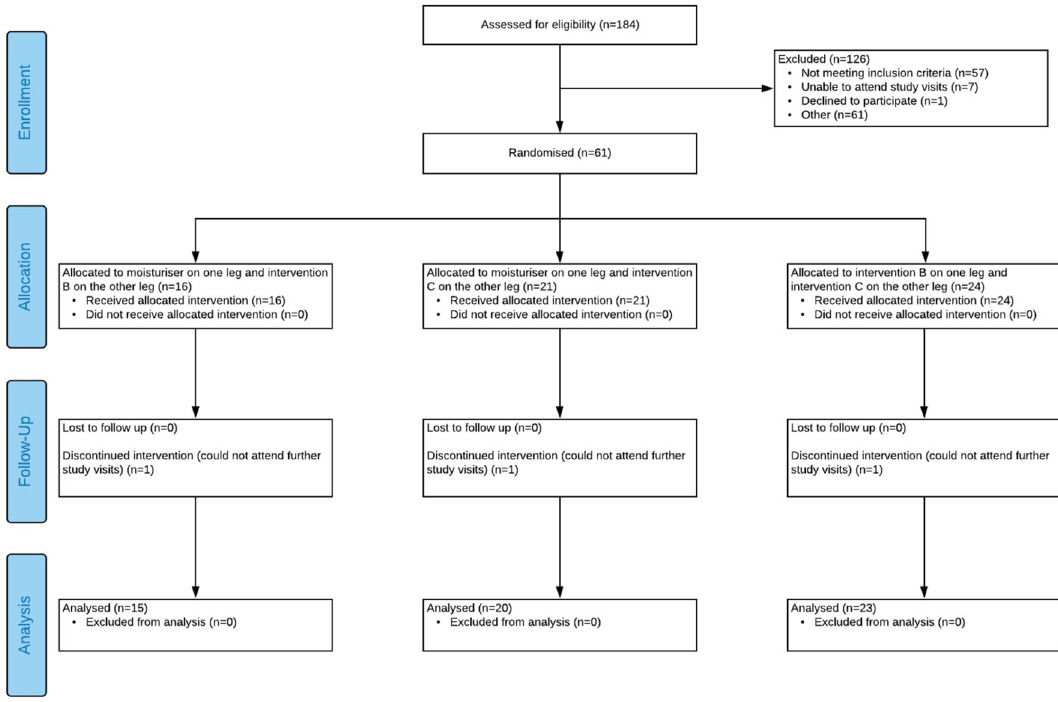
Figure 5. CONSORT 2010 flow diagram. Application of lotion application to legs of subjects classified as having cosmetic dry